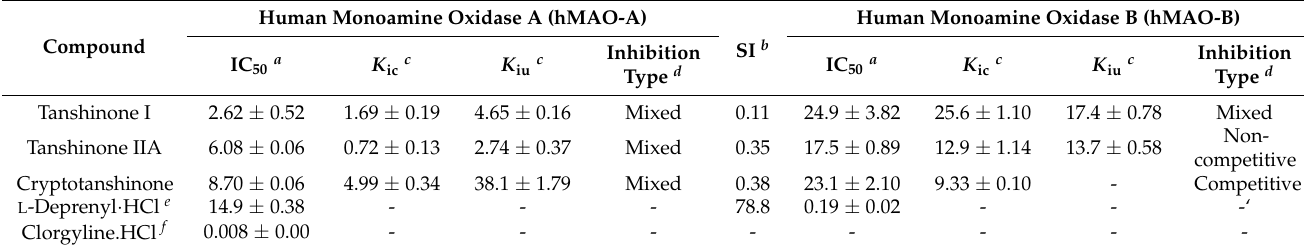
Table 1. Inhibitory activities of tanshinone I, tanshinone IIA, and cryptotanshinone against recombinant human monoamine oxidase A and B and their enzyme kinetic